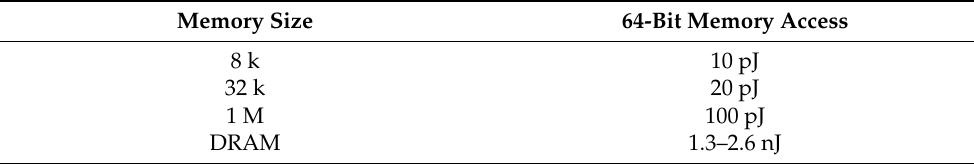
Table 2. Breakdown of the energy consumption for memory access [5]. Adapted with permission from ref. [5]. Copyright 2014